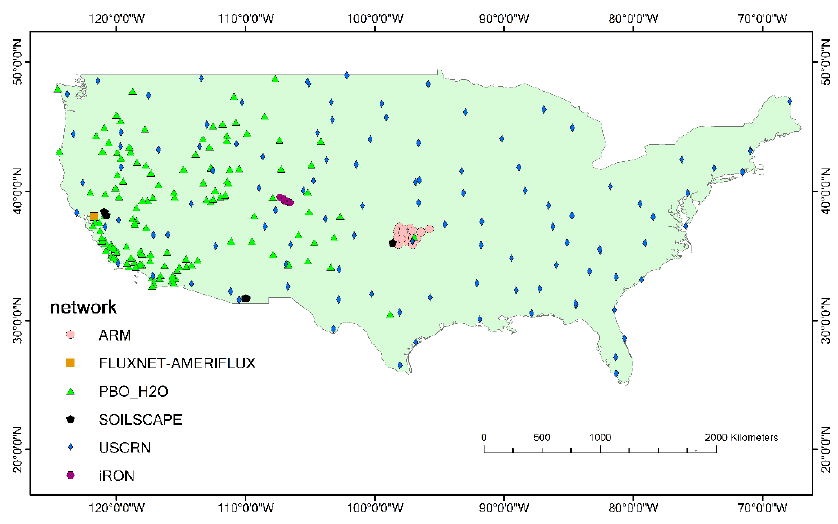
Figure 1. ISMN observation network distribution in the continental US.